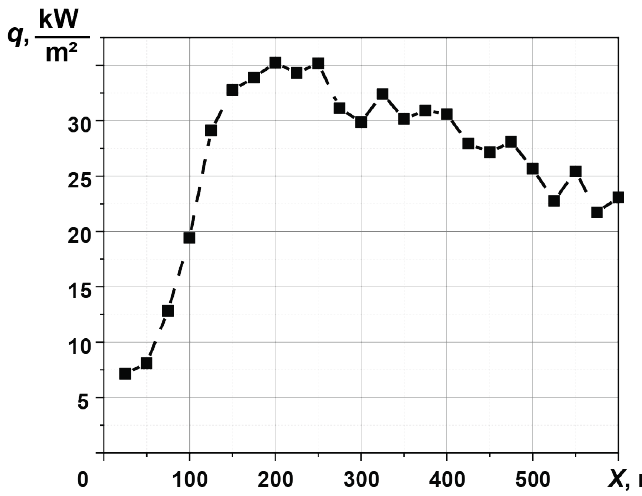
Figure 12. Local heat flux along the diesel